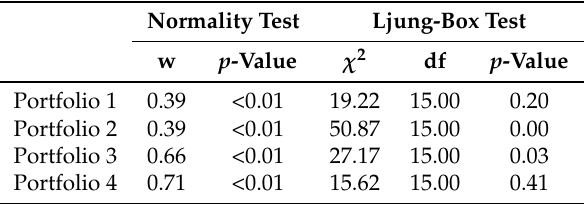
Table A1. Diagnosis of one-factor residuals models.